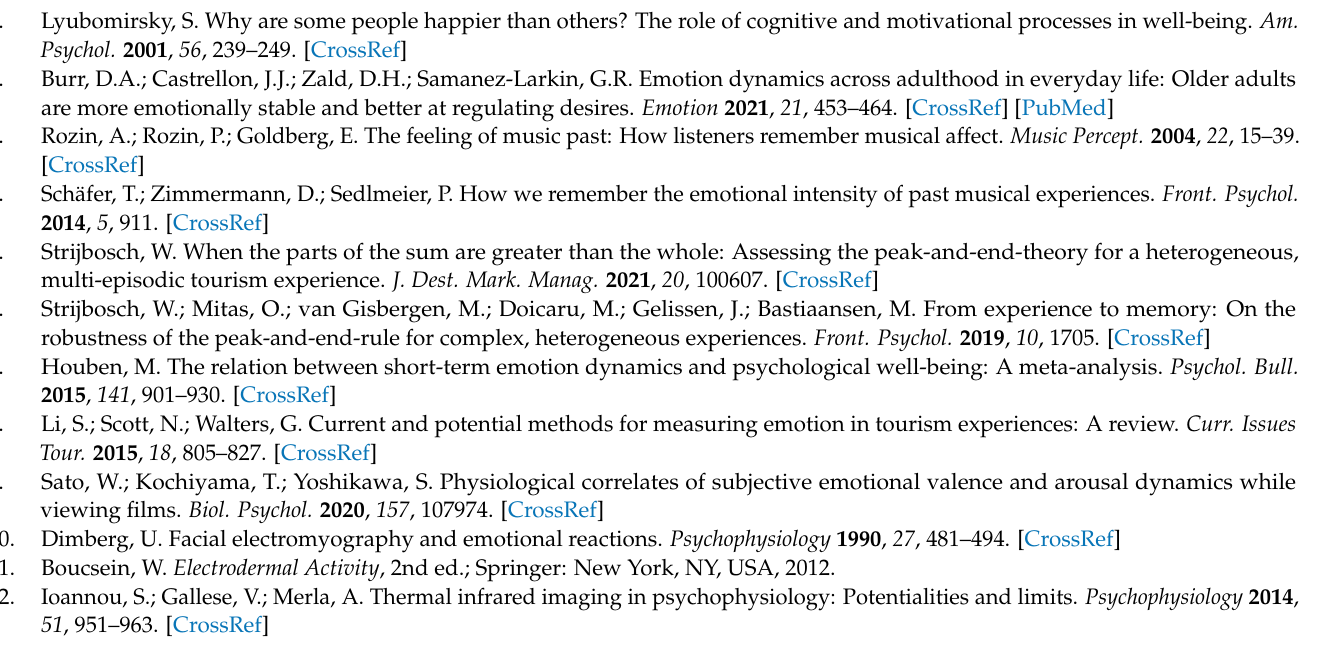
Table S4: Second-by-second corrugator supercilii electromyography ( µ V); Table S5: Second-by-second zygomatic major electromyography ( µ V); Table S6: Second-by-second trapezius electromyography ( µ V); Table S7: Second-by-second electrodermal activity ( µ S); Table S8: Second-by-second fingertip temperature ( ◦